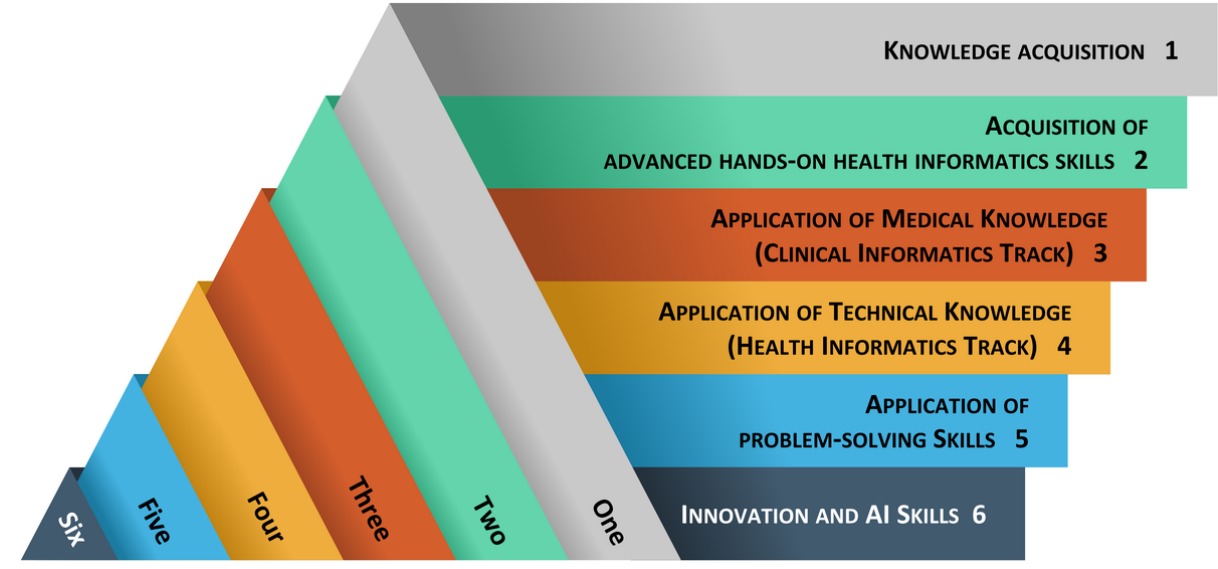
Figure 1. Proposed health informatics competency framework. AI: artificial